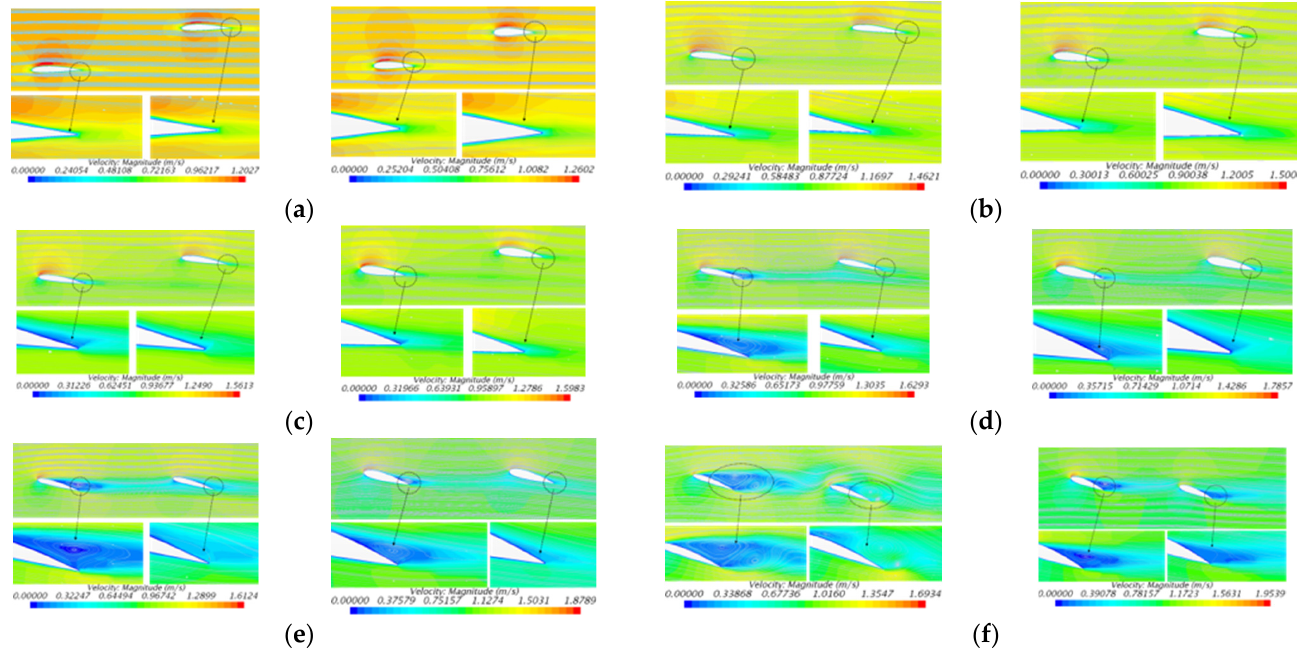
Figure 12. Velocity and streamline distribution in the middle longitudinal section of the wing at different angles of attack: α = 0 ◦ ( a ), α = 6 ◦ ( b ), α = 8 ◦ ( c ), α = 12 ◦ ( d ), α = 15 ◦ ( e ), α = 20 ◦ ( f ) (in each sub-image, left : NACA2412; right : NACA2418).